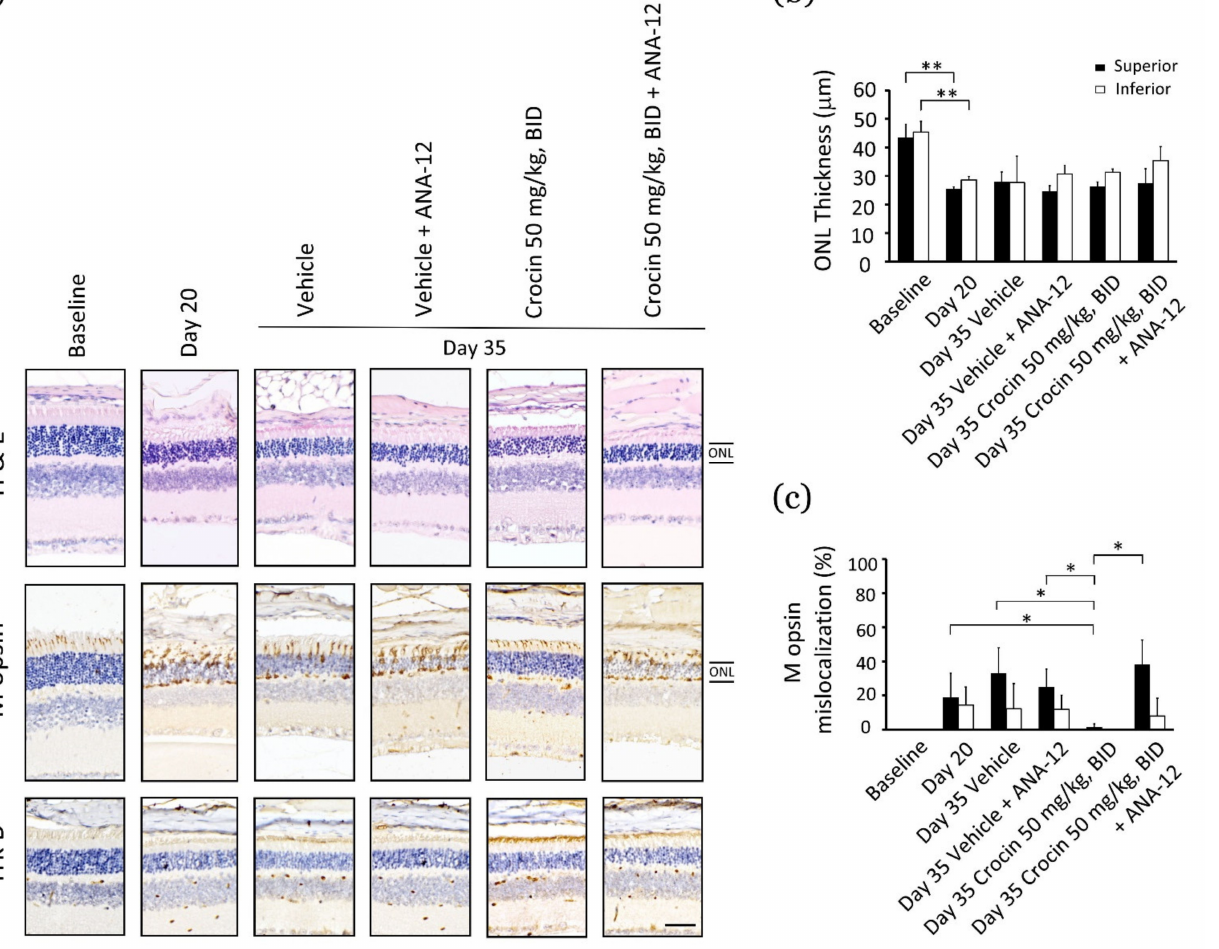
Figure 3. Crocin modulates M opsin protein localization to function via activating the BDNF– TrkB pathway. ( a ) The change in ONL thickness, M opsin protein, TrkB protein in retinas; ( b ) the average ONL thickness; ( c ) the percentage of M opsin mislocalization. Data are expressed as the mean ± standard error (SE). Mann–Whitney U test. ** p < 0.01, and * p < 0.05. Scale bar: 40 µ m. ONL, outer nuclear layer; H&E, hematoxylin and